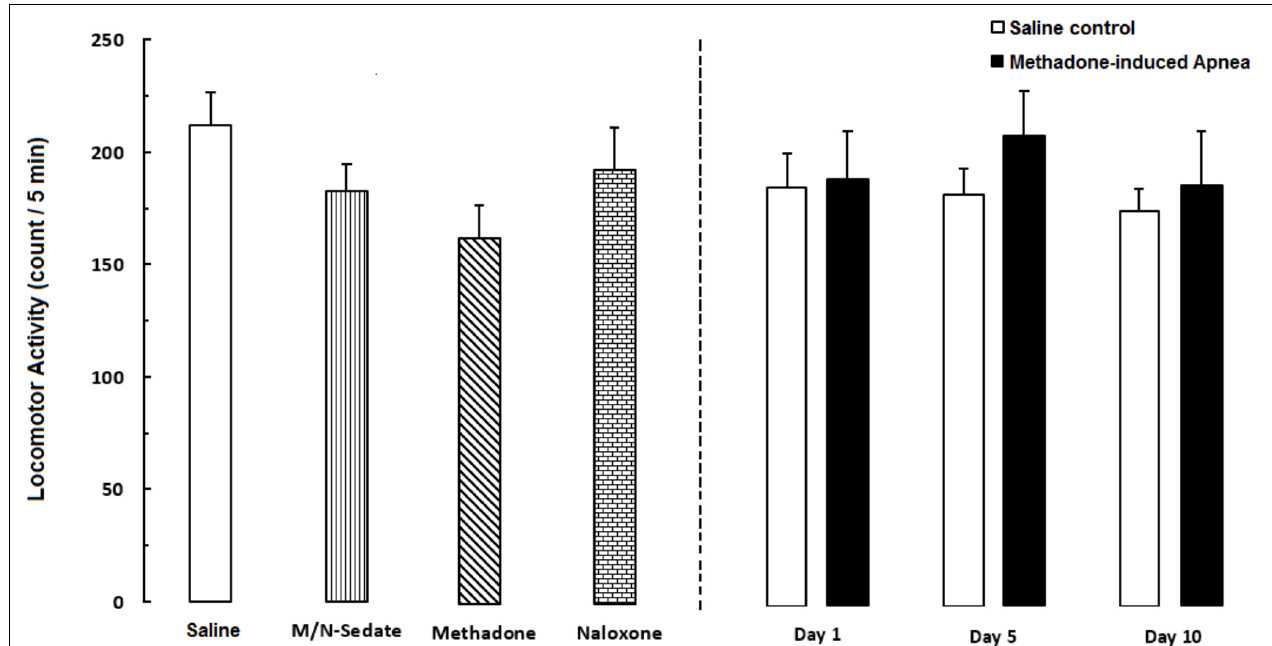
FIGURE 6 | Locomotor activity was recorded by using photobeam activity system during a 5-min session in different groups, including; M/N-treated groups (a single dose of naloxone was administered after methadone overdose in apnea stage, in animals which experienced apnea and locomotor activity was evaluated either on day 1, 5, or 10 day post-resuscitation; M/N-Day 1 ( n = 10), M/N-Day 5 ( n = 6) and M/N-Day 10 ( n = 6) groups and their respective Saline control groups; n = 6; right panel), M/N-Sedate ( n = 11; a single dose of naloxone was administered after methadone overdose immediately in the initial stage of sedation state, so behavioral evaluation was carried out only 1 day after drug administration), Saline; n = 14, methadone; n = 12 and naloxone; n = 8 (saline, methadone or naloxone was administered alone in separated groups in which locomotor activity was evaluated 1 day after drug administration) groups. Animals received methadone (15